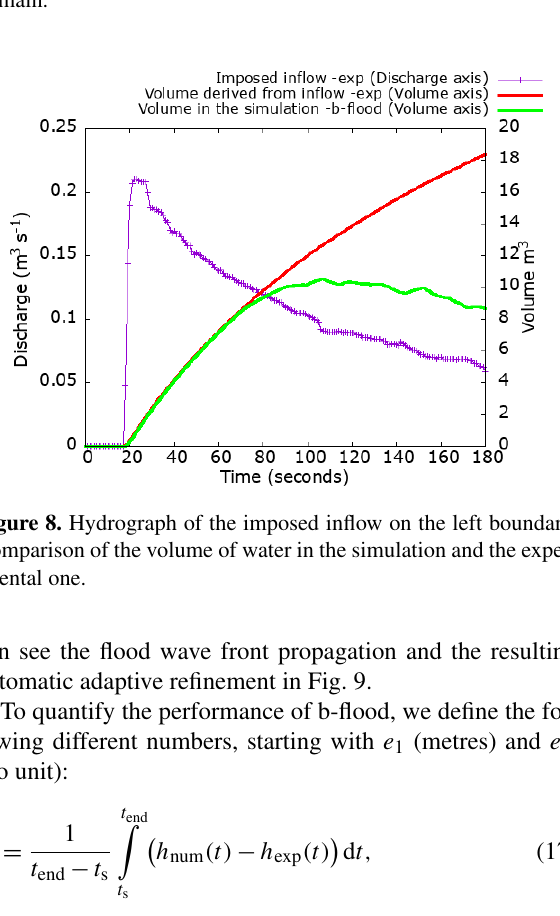
Figure 7. Topography of the fluvial case with the position and name of the gauge stations. The inflow is coming from the left border of the domain.